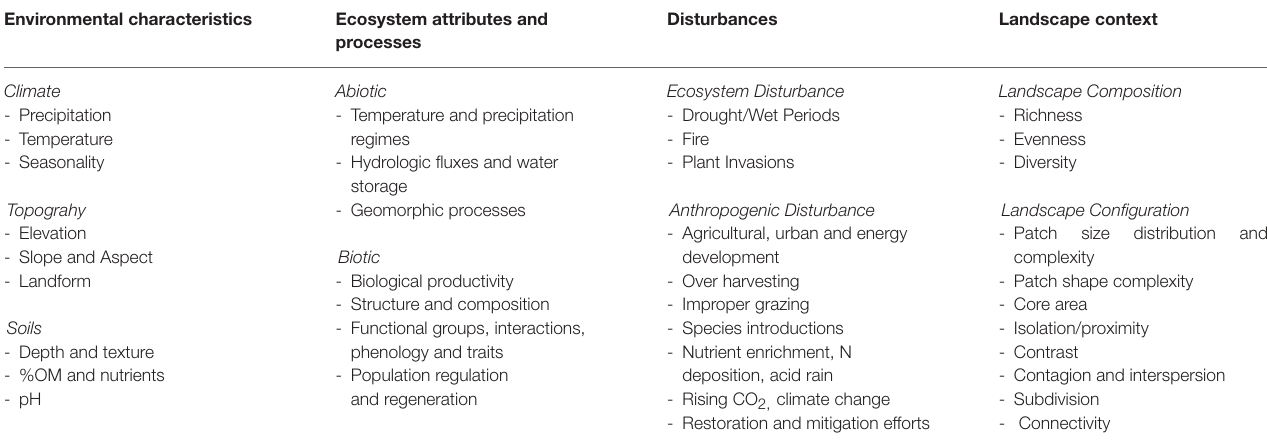
TABLE 2 | The factors that contribute to general and spatial resilience to fire and resistance to invasive annual grasses and selected indicator variables for each factor. Environmental